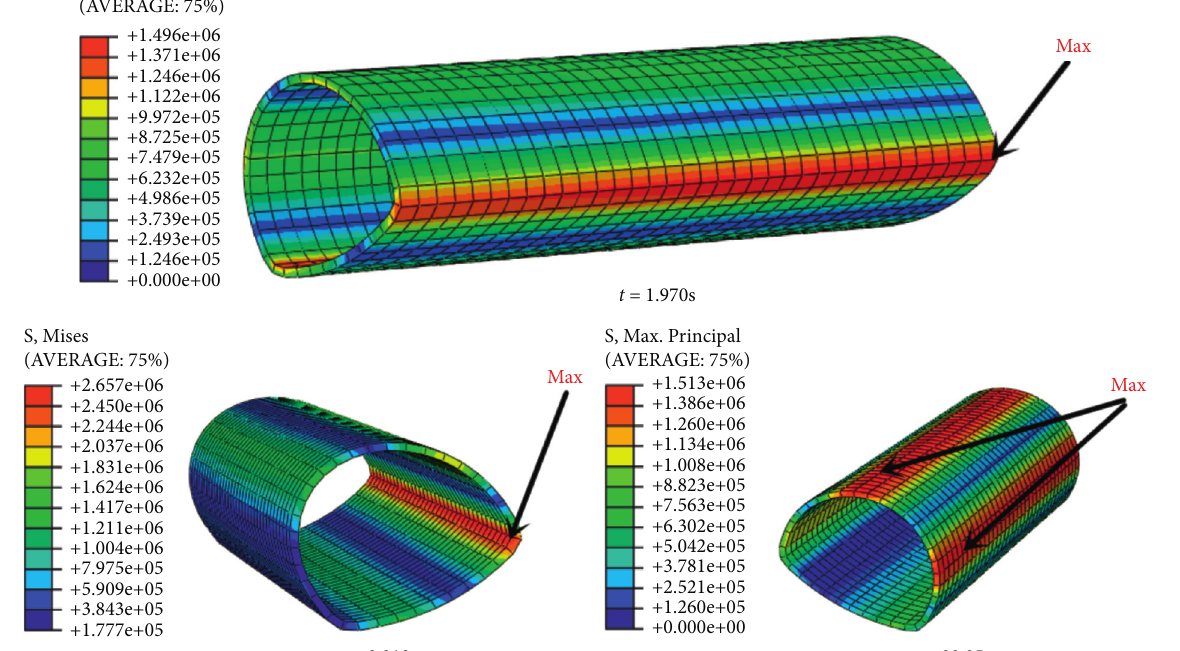
Figure 15: Maximum